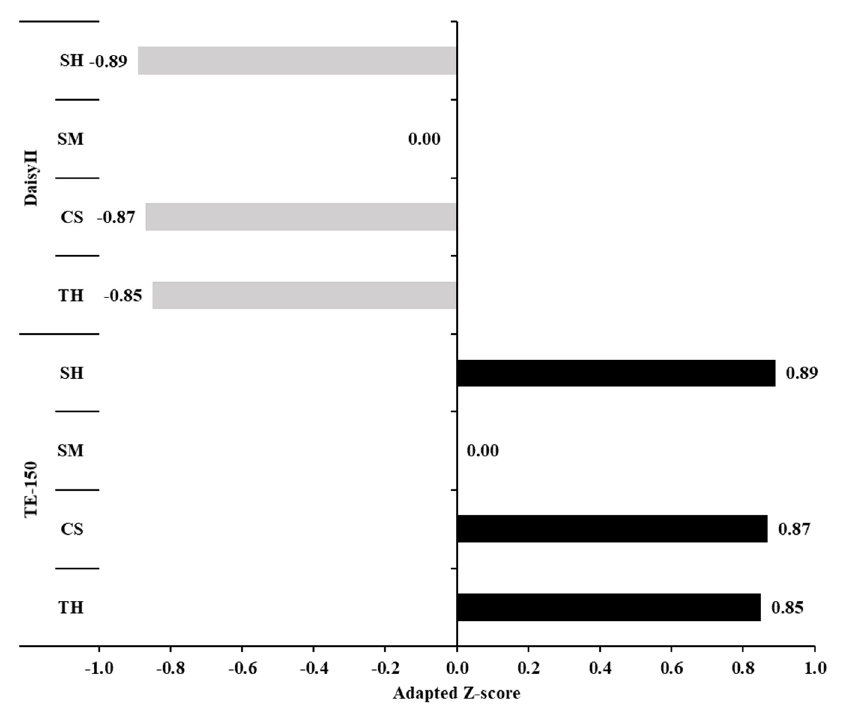
Figure 5. Adapted Z-scores for the in vitro dry matter digestibility for the evaluated equipment types with different feeds (TH, Tifton 85 hay; CS, corn silage; SM, soybean meal; and SH, soybean hulls). For details, see Equation (14).